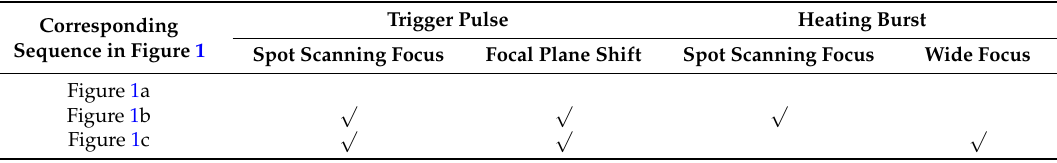
Table 1. Example of combination of beamforming technics for trigger high-intensity focused ultrasound (HIFU) sequence.